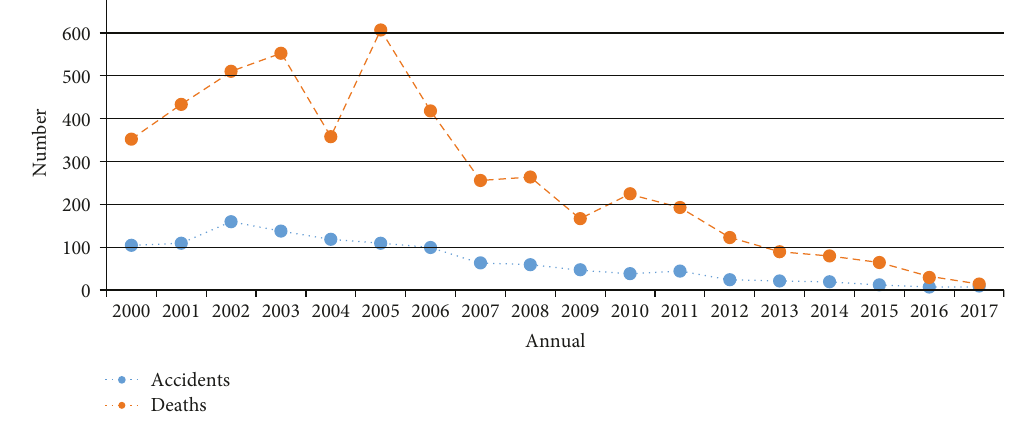
Figure 1: Feature of coal mine water disasters that occurred in China in recent